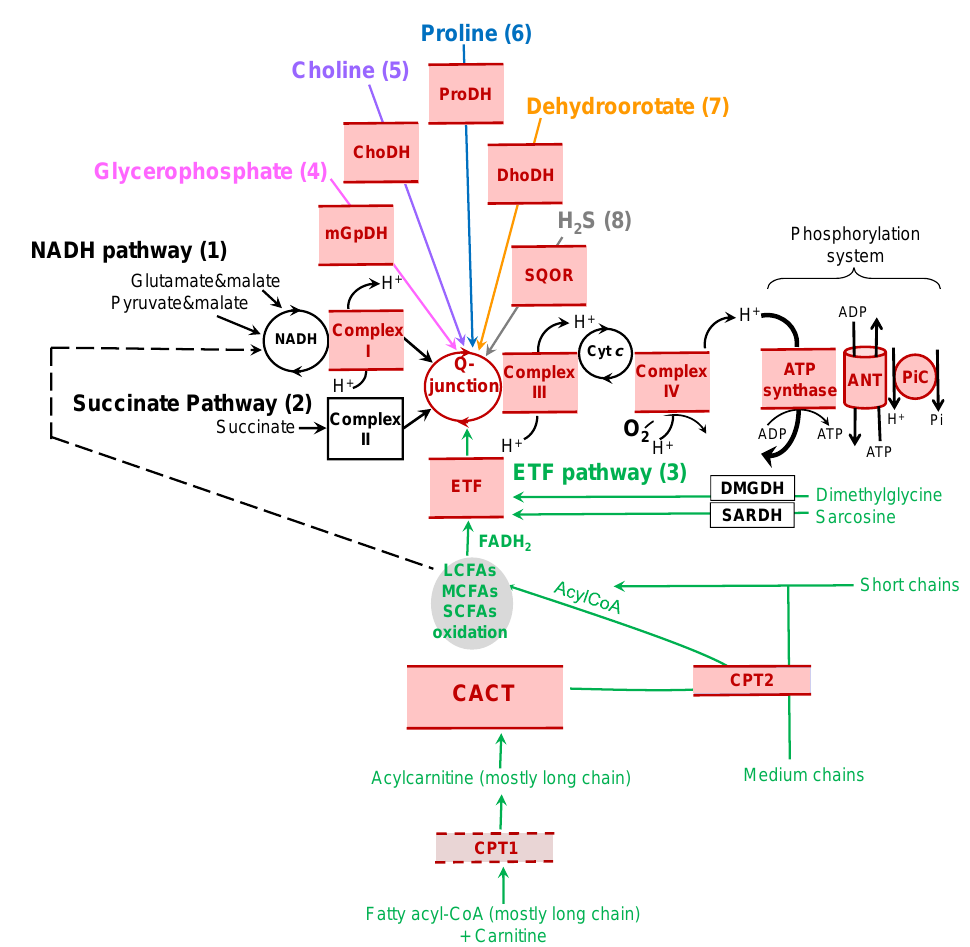
Figure 1. Electron entrance in oxidative phosphorylation (OXPHOS). The main entry points con- verging at the Q-junction (ubiquinol/ubiquinone) of the OXPHOS system are illustrated here and described as numbers 1 to 8. (1) The NADH pathway provides electrons to complex I of the electron transport system. These electrons can be provided — among others — by pyruvate (through pyruvate dehydrogenase), and glutamate (through glutamate dehydrogenase). (2) The succinate pathway uses succinate dehydrogenase to reduce FAD and feed complex II. (3) The electron-transferring fla- voprotein (ETF) pathway (in light green) receives electrons from fatty acyl-CoA of various chain lengths. The carnitine shuttle system is composed of carnitine palmitoyltransferase 1 (CPT1), car- nitine – acylcarnitine translocase (CACT), and carnitine palmitoyltransferase 2 (CPT2). Oxidation of the long-chain fatty acids (LCFAs) depends on the carnitine shuttle system, whereas the oxidation of short- (SCFAs) and medium- (MCFAs) chain fatty acids are largely independent of that system (reviewed by [12]). Once in the mitochondrial matrix, the fatty acids enter the process of long-chain, medium-chain, or short-chain fatty acid oxidation. In this process, NAD and FAD are reduced to NADH and FADH 2 ; FADH 2 is used as a substrate for electron-transferring flavoprotein (ETF), while NADH feeds complex I. Both NADH and FADH 2 provide electrons into the Q-junction. The dashed line links LCFA, MCFA, and SCFA oxidation to the NADH pathway, which is not rate-limiting for the ETF pathway. Malate is also provided, with all fatty acid substrates, as a metabolite in the citric acid cycle to prevent the accumulation of acetyl-CoA and the concurrent inhibition of fatty acid oxidation. Dimethylglycine dehydrogenase (DMGDH) and sarcosine dehydrogenase (SARDH) can also feed electrons through the ETF pathway. (4) Glycerophosphate oxidation (in pink) occurs via mitochondrial glycerophosphate dehydrogenase (mGpDH) and shuttles electrons through FADH 2 directly to the Q-junction. (5) Choline oxidation (in purple) occurs through choline dehydrogenase (ChoDH), which reduces FAD. (6) Proline dehydrogenase (ProDH, in blue) catalyzes proline oxida- tion and FAD reduction. (7) The dihydroorotate (Dho, in orange) is transformed into orotate by dihydroorotate dehydrogenase (DhoDH), releasing an electron from flavin mononucleotide directly into the Q-junction. (8) sulfide:quinone oxidoreductase (SQOR, in grey) oxidizes H 2 S and transfers an electron into the Q-junction. After convergence of electrons from diverse pathways at the Q-